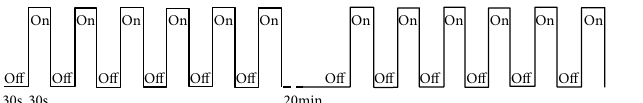
Figure 3: Every functional scan run for 6min constituting six OFF – ON blocks; the duration interval between the two functional scans was 20min. During the six ON blocks of each functional scan, the laser was irradiated on the photosensitive analgesic patch or the photosensitive algetic